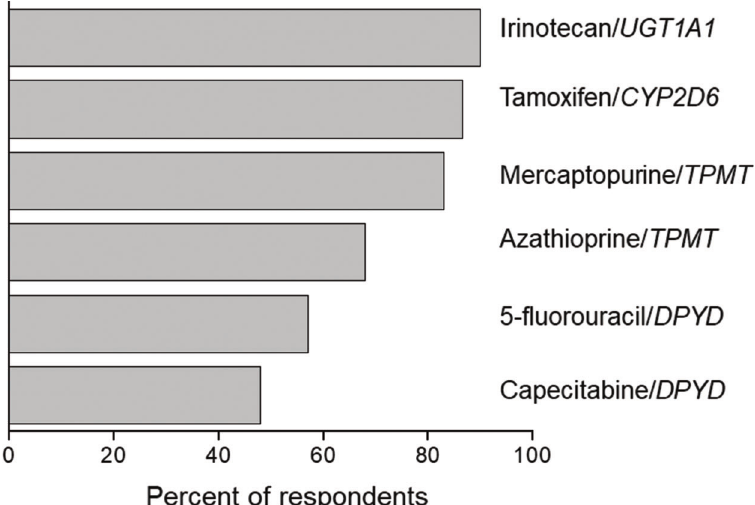
Figure 3 - Data from a survey among United States physicians on their perception of the clinical relevance of PGx information. The bars correspond to the percentage of respondents who rated the antineoplastic/gene pairs listed on the right as 1 or 2 (on a scale of 1-5, where 1 is the most relevant). Source: Relling and Klein